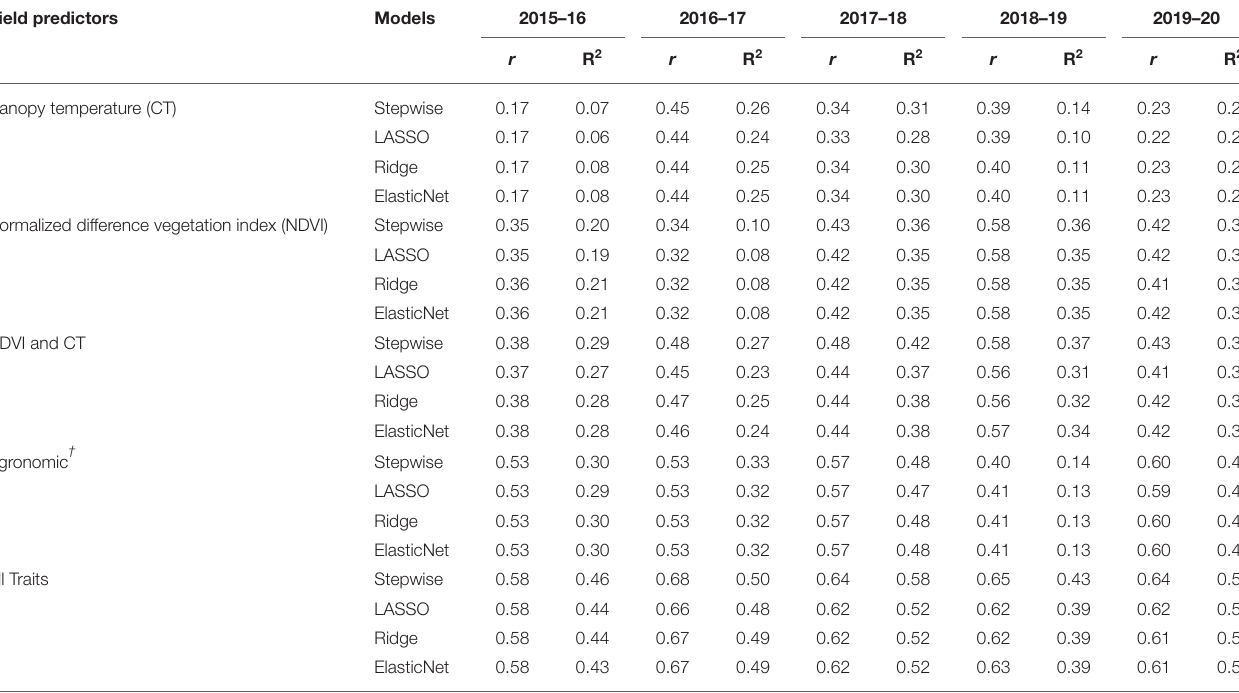
TABLE 2 | Yield prediction accuracies for five wheat growing seasons from 2016 to 2020 in Jamalpur, Bangladesh, using four different multivariate models. Yield